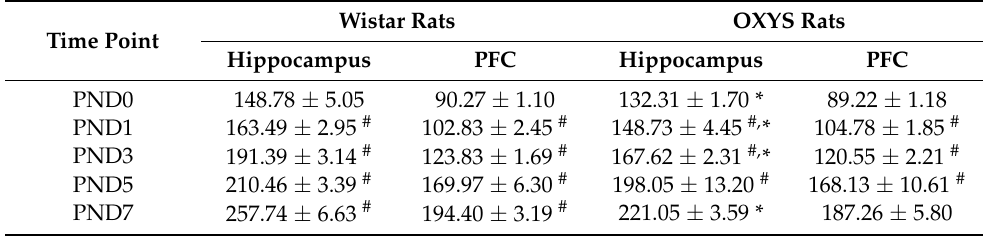
Table 2. The size of neuronal nuclei in the hippocampus and PFC of OXYS and Wistar pups ( µ m 2 ). Wistar Rats OXYS Rats Time Point